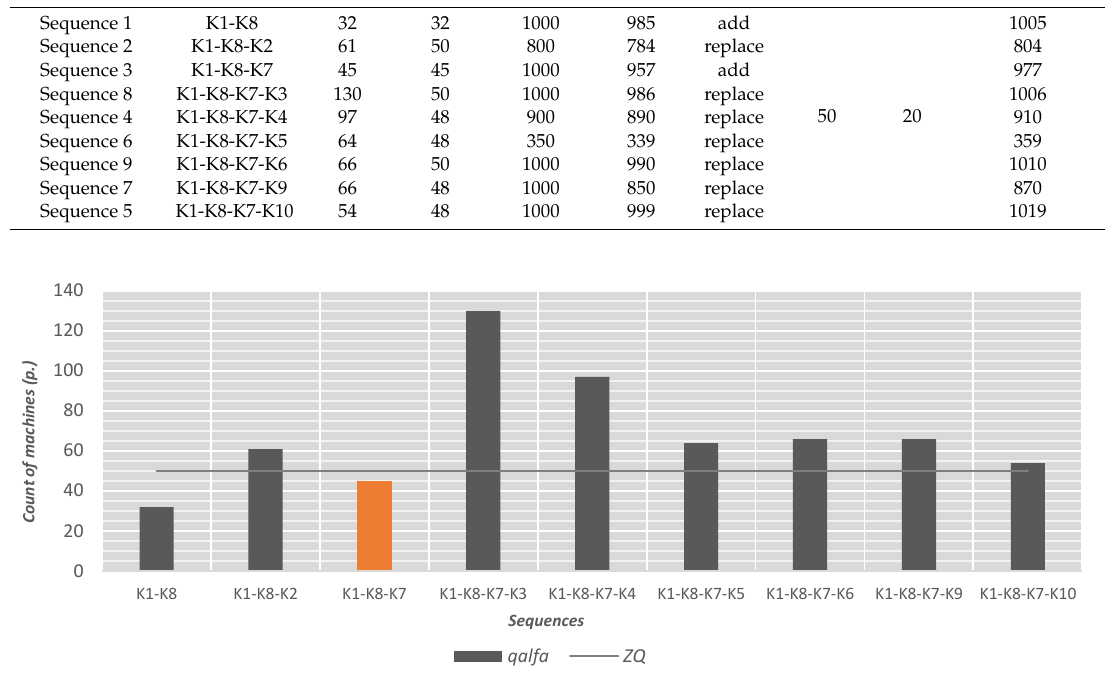
Figure 3. The chart of final configuration with taking into account the condition.